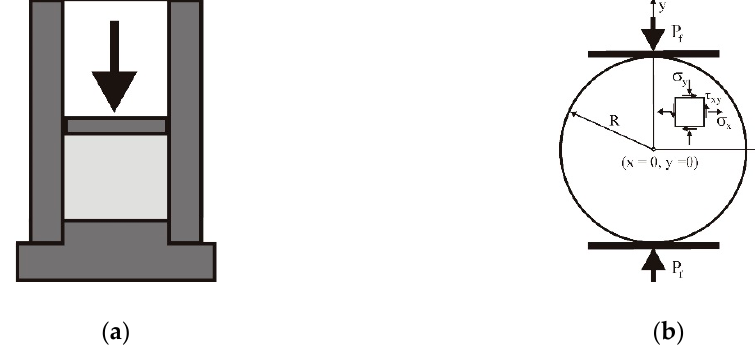
Figure 1. Schematics of the experimental setup: ( a ) compaction, ( b ) diametral compression test.